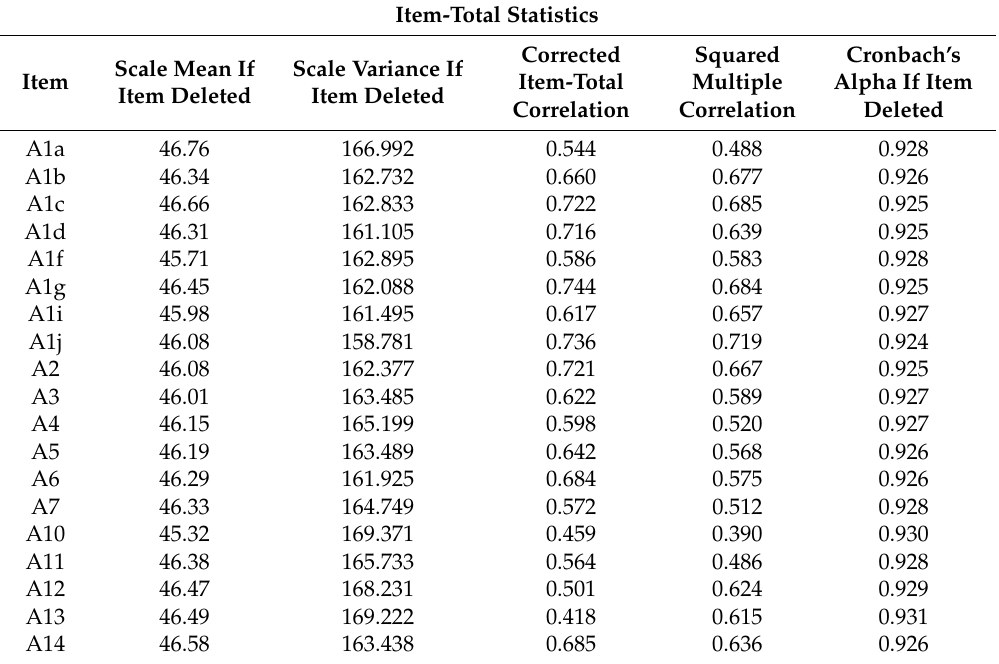
Table 6. Factor 1 corrected item total correlation and Cronbach’s alpha if deleted.